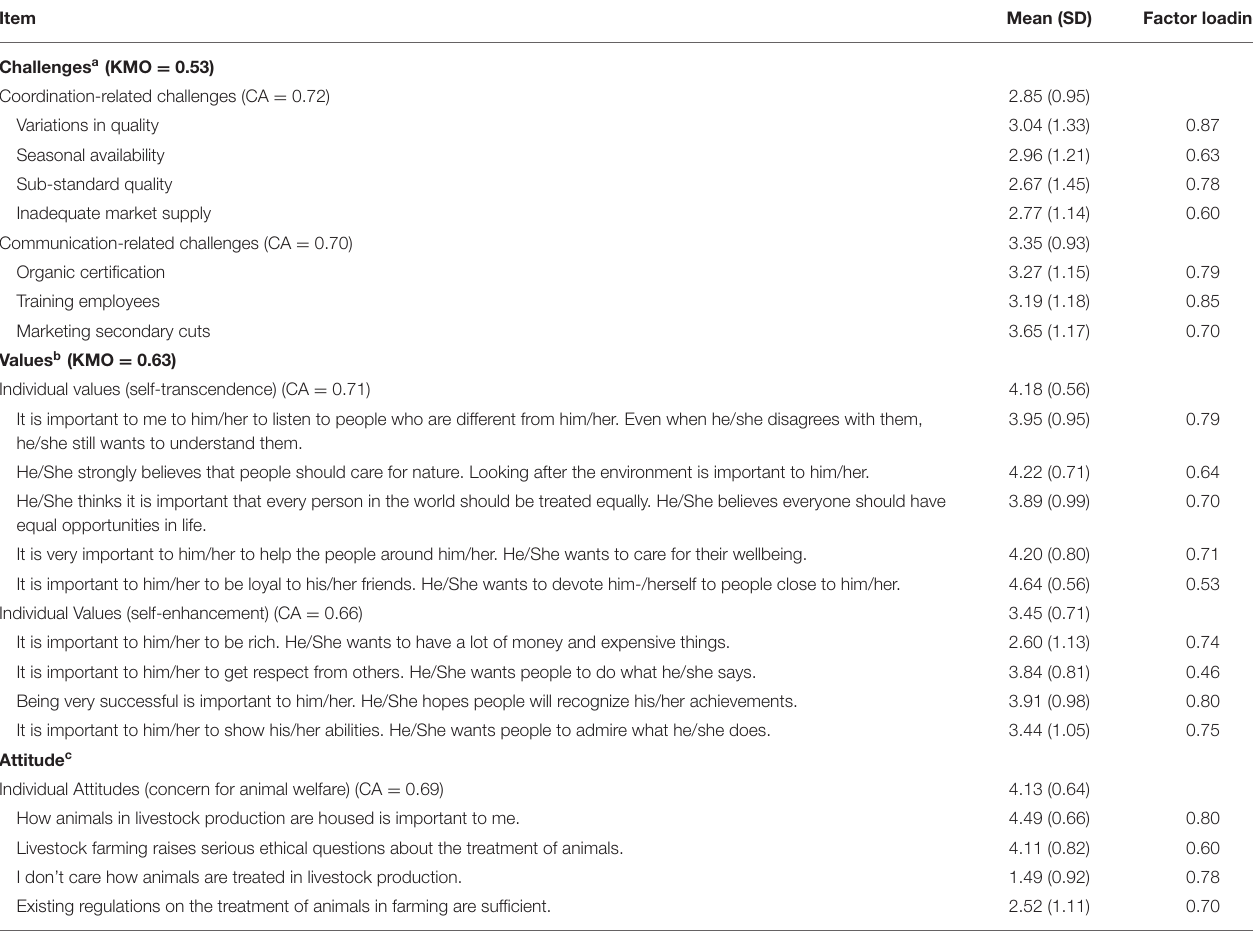
TABLE 3 | Results of the Principal Component